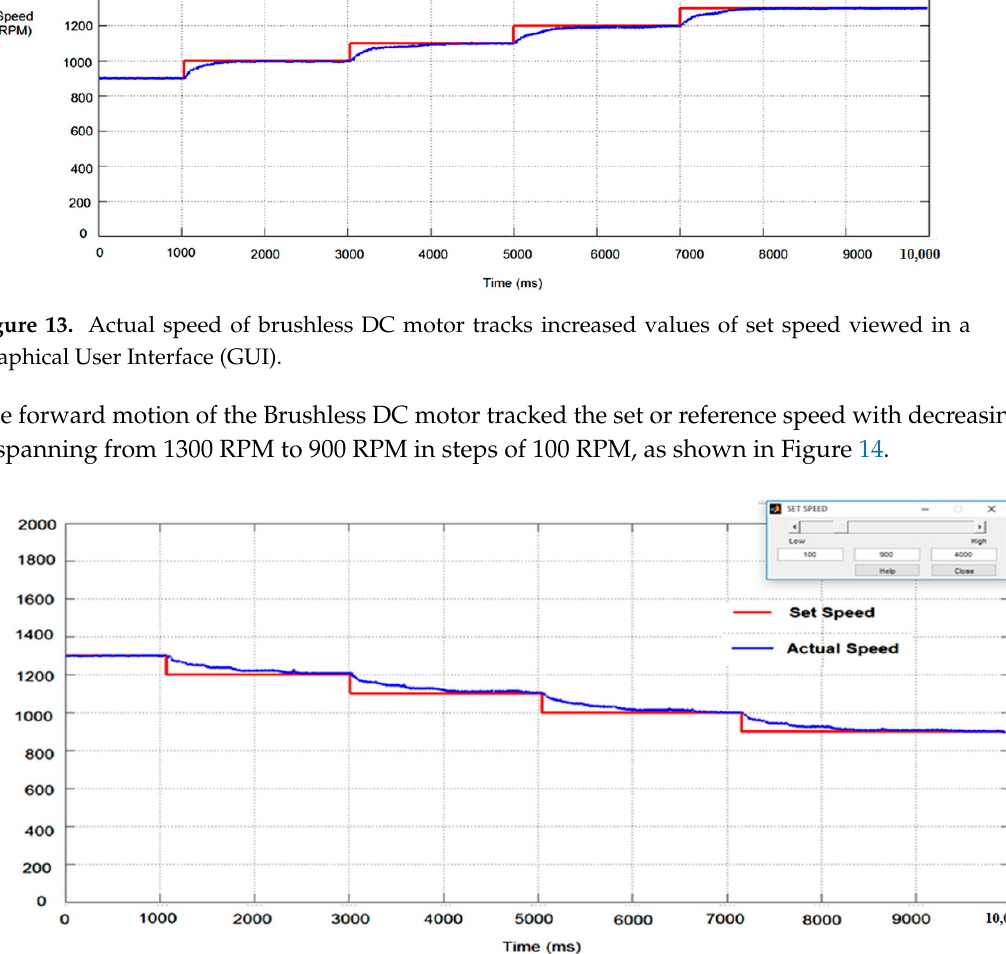
Figure 14. Actual speed of the brushless DC motor tracked decreasing values of set speed, as viewed in the GUI.